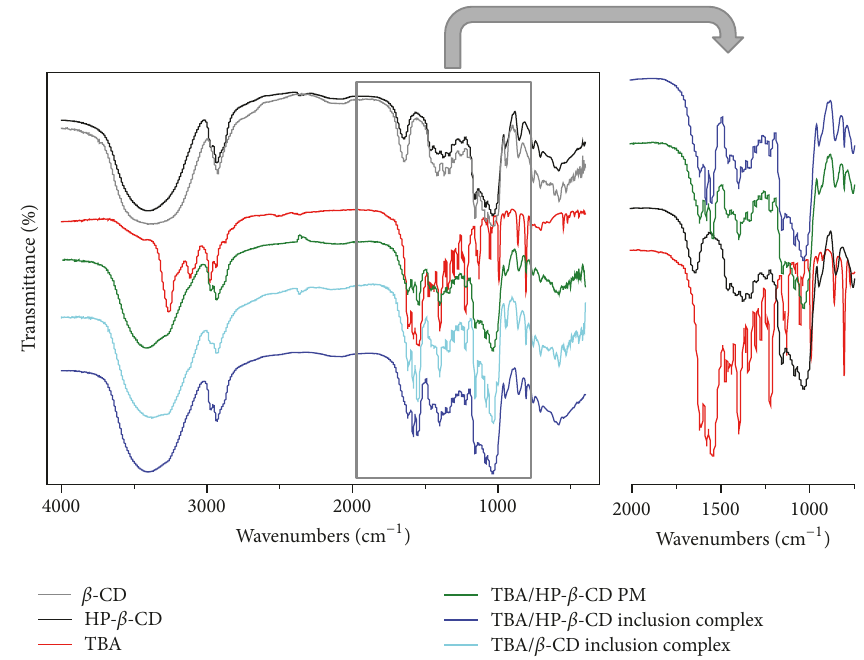
Figure 5: FTIR spectra of (— dark gray) 𝛽 -CD; (— black) HP- 𝛽 -CD; (— red) terbuthylazine; (— green) terbuthylazine/HP- 𝛽 -CD physical mixture; (— turquoise) terbuthylazine/ 𝛽 -CD inclusion complex; and (— blue) terbuthylazine/HP- 𝛽 -CD inclusion complex.